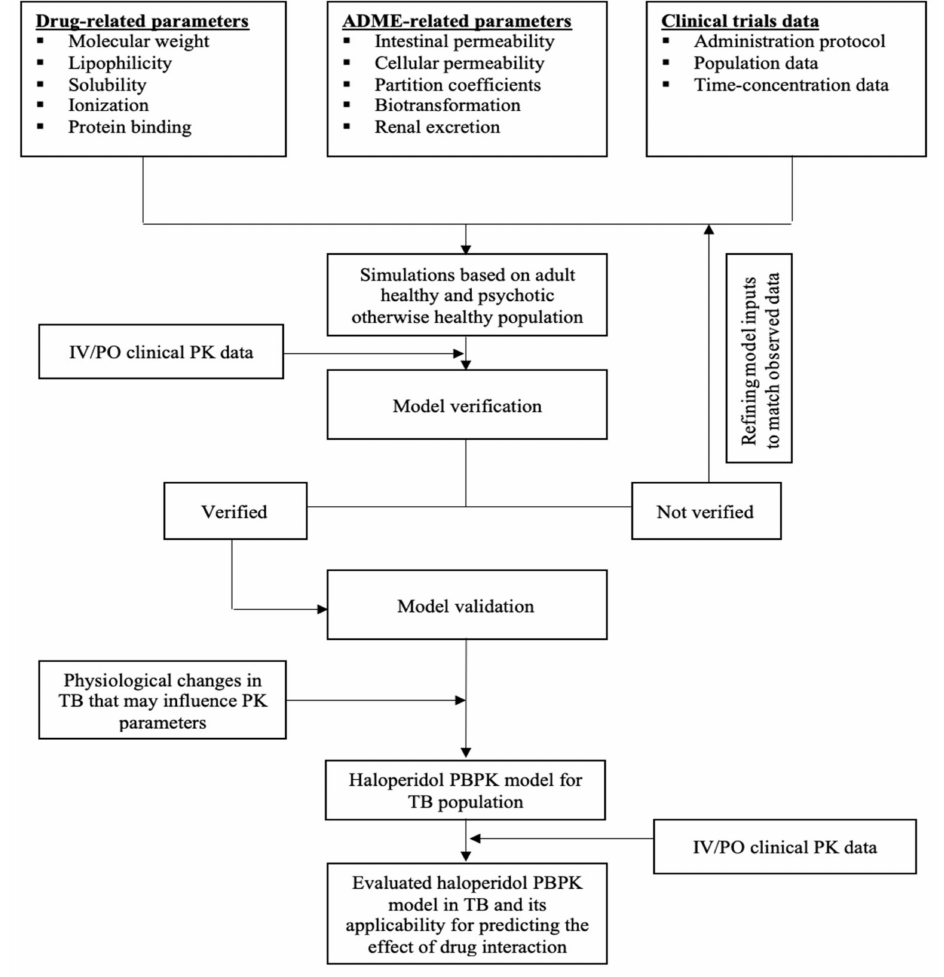
Figure 1. Workflow for the development of haloperidol PBPK